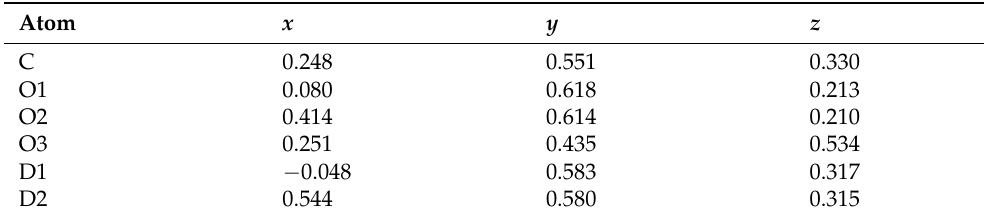
Table A4. Alternative lowest-energy DFT-optimized (PBE-D3) spatial parameters for deuterated carbonic acid at 2 GPa in space group P 2 1 / c with a = 6.4970, b = 5.6645, c = 5.2611 Å, β = 90.77 ◦ ; see also text.